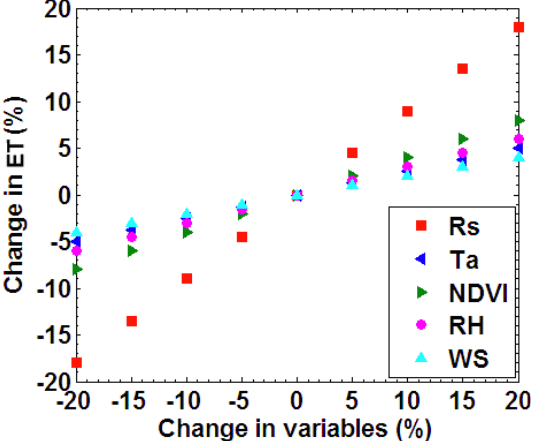
Figure 3. Sensitivity analysis of the estimated ET with the corresponding input variables,